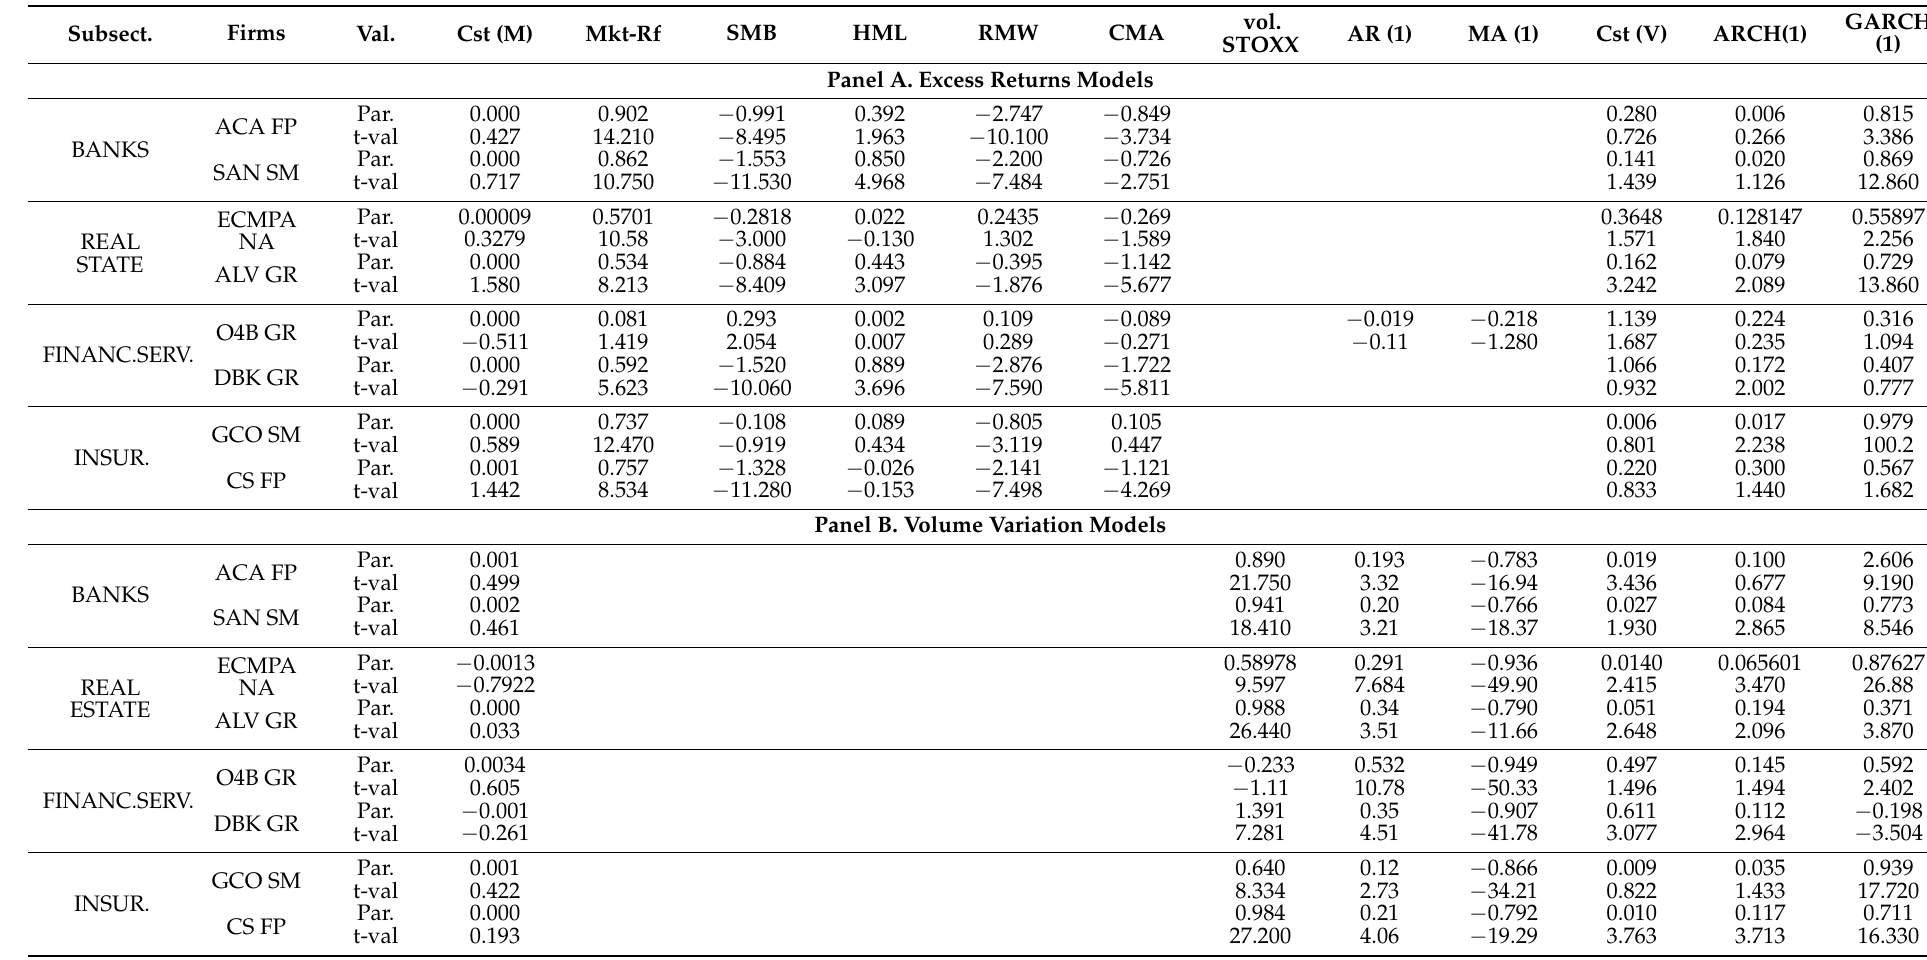
Table 2. Estimate of the models to obtain the